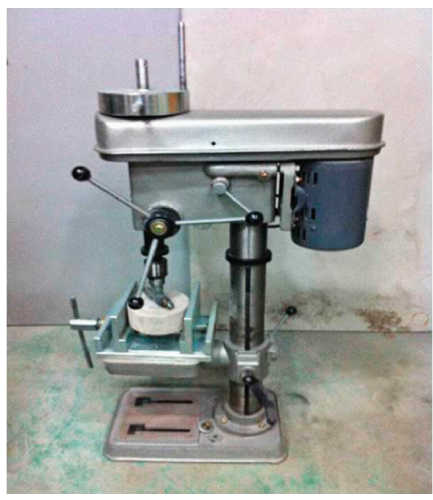
Figure 6: Abrasion test